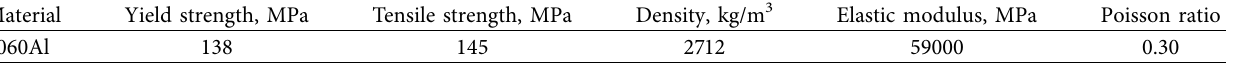
Table 1: The property of 1060 aluminum.